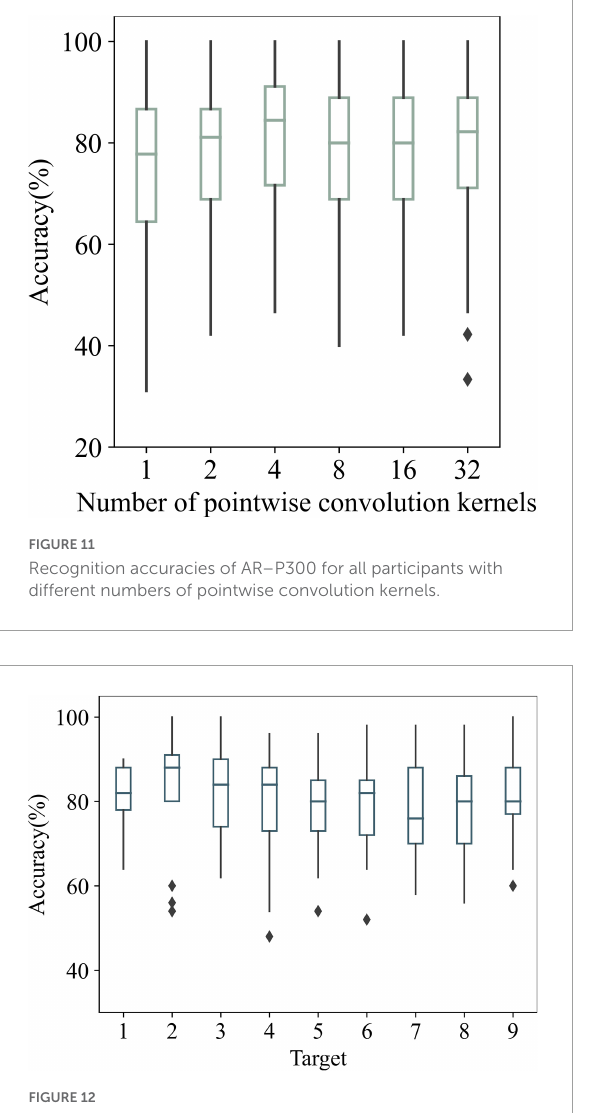
TABLE 6 Recognition times of the two CNNs for 90 AR–P300